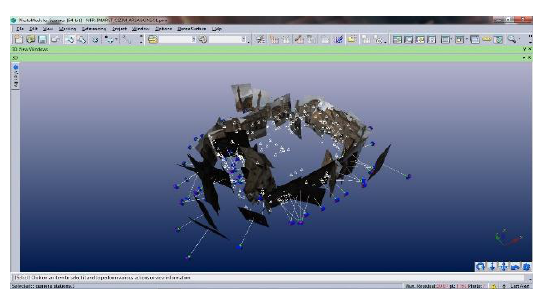
Figure 4: Camera calibration parameters